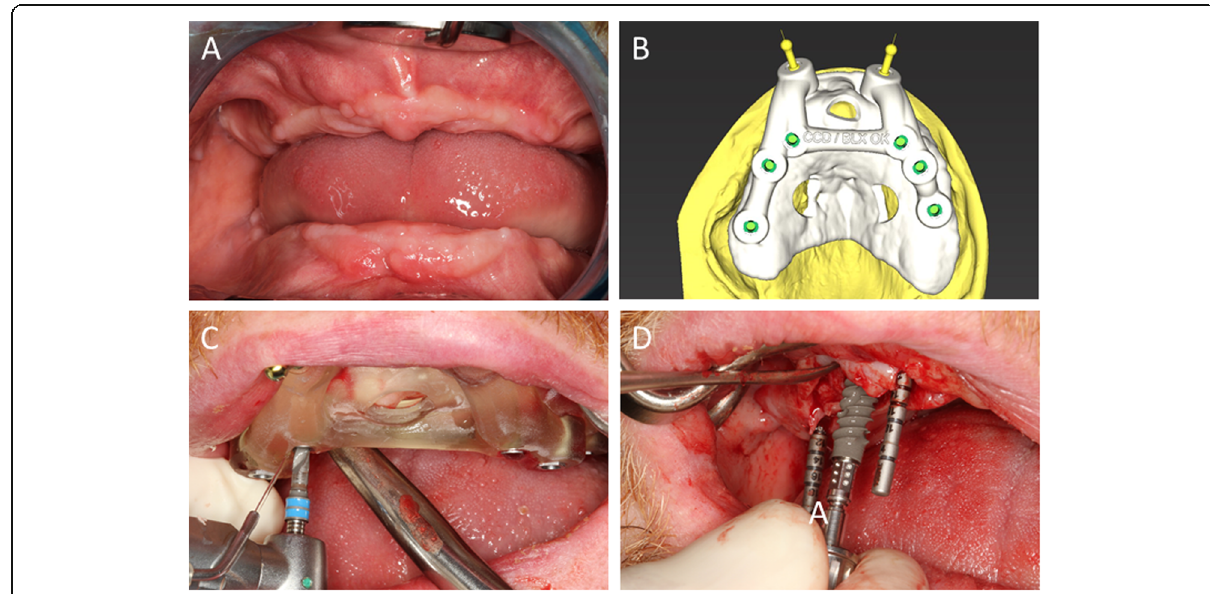
Fig. 4 a The condition 6 months after surgical removal of all teeth. b Construction of the drilling template. c Stabilization of the template using transverse pins. Pilot holes being drilled using the template. d Further preparation and implant insertion being performed in a conventional